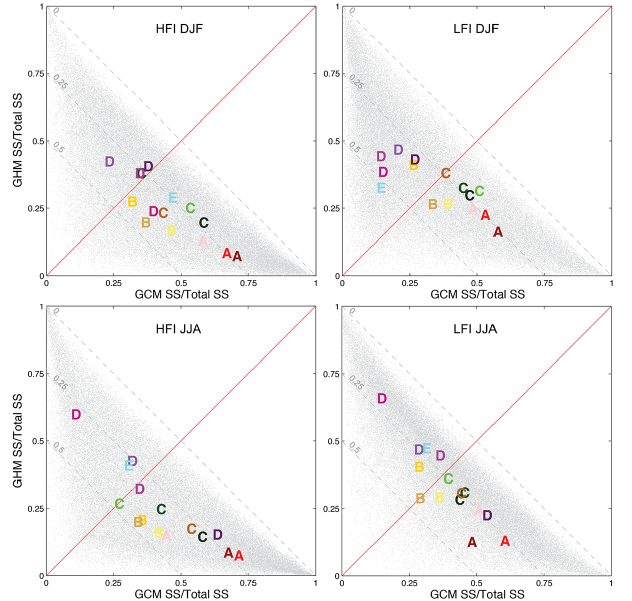
Figure 6. As Fig. 5, for the seasons DJF (top) and JJA (bottom).